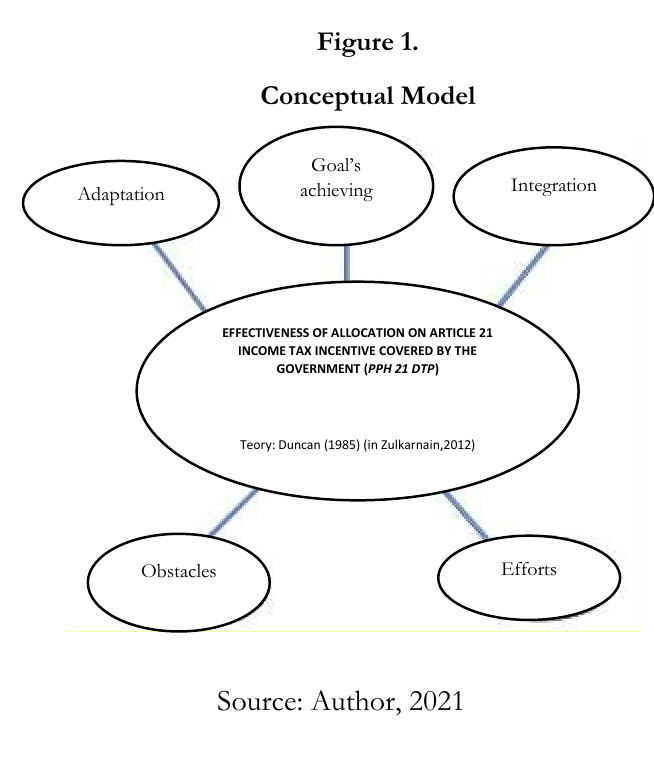
Figure 1. Conceptual